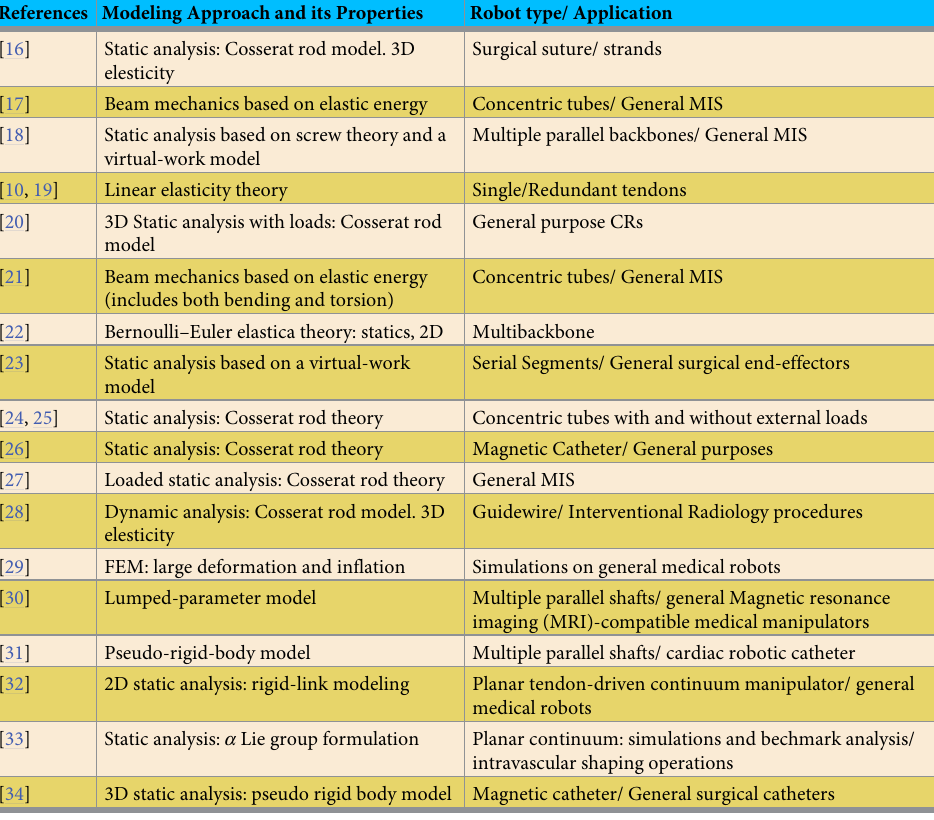
Table 1. References on dynamics/static analysis of soft continuum manipulators in surgical robotics field. References Modeling Approach and its